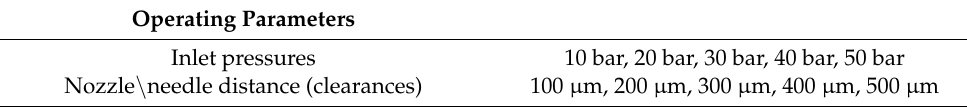
Table 4. Values of Operating